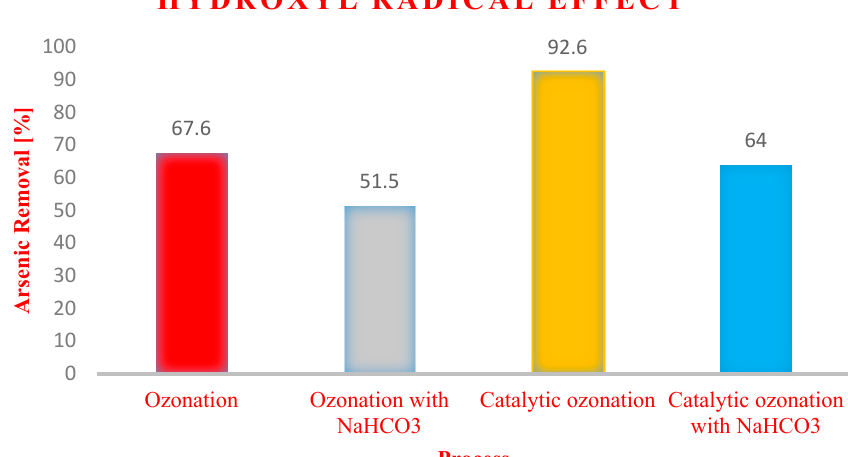
Figure 13. Arsenic % removal in ozonation and catalytic ozonation processes with and with out NaHCO 3 (initial As = 68 ± 8 ppb, ozone dose = 0.2 mg/min, O 3 /Fe-ZA dose = 10 g/L, pH = 8.2 ± 0.3, volume = 1 L, time = 30 min, T = 33 ± 2 ◦ C, t = 30 min, NaHCO 3 = 50 mg/L).